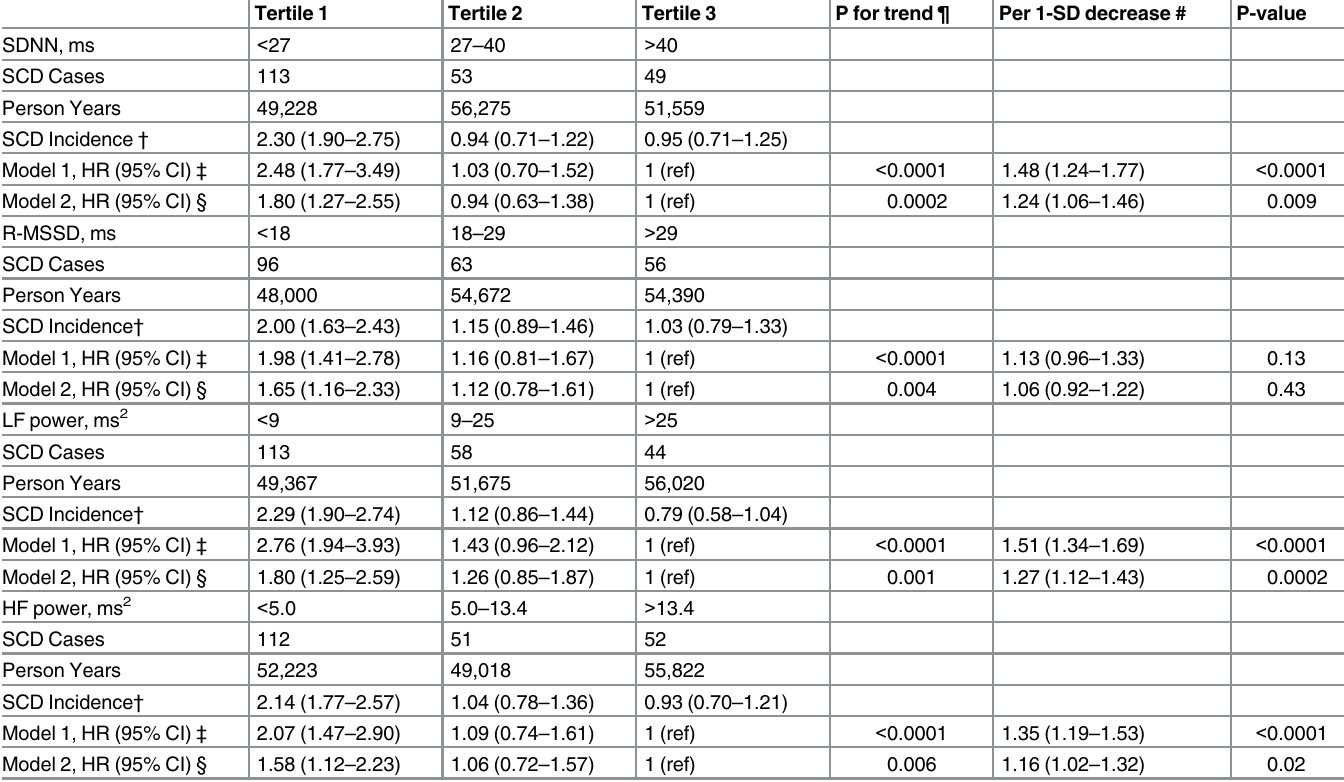
Table 2. Hazard Ratios of Sudden Cardiac Death for Heart Rate Variability Measures, Atherosclerosis Risk in Communities Study, 1987 –